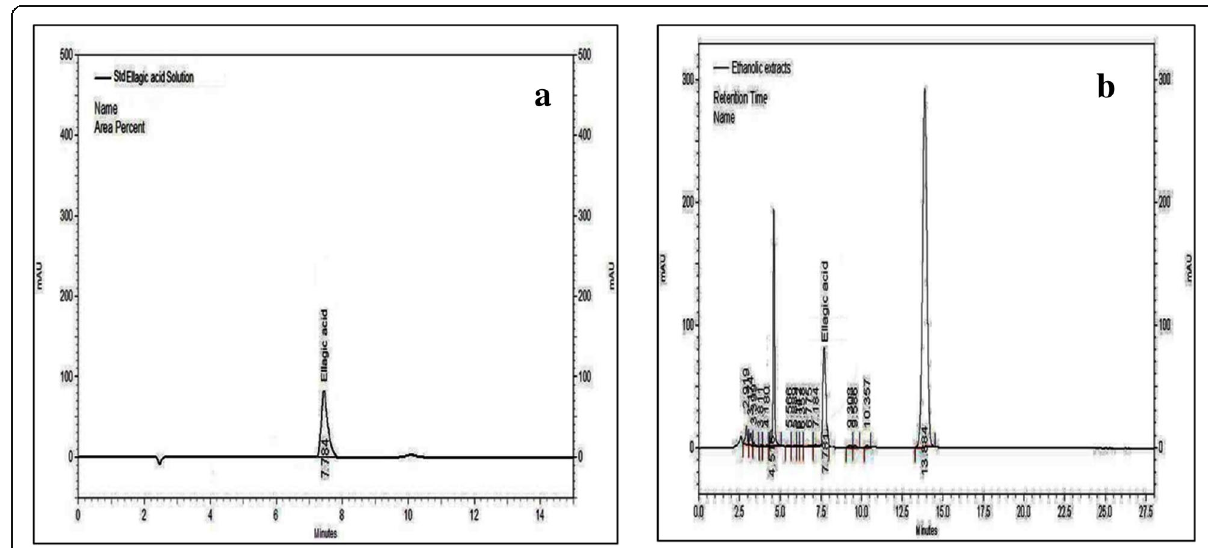
Fig. 1 a HPLC Chromatogram of ALEE. a Ellagic acid ( b ) Ethanolic extract of stem bark of Anogeissus latifolia